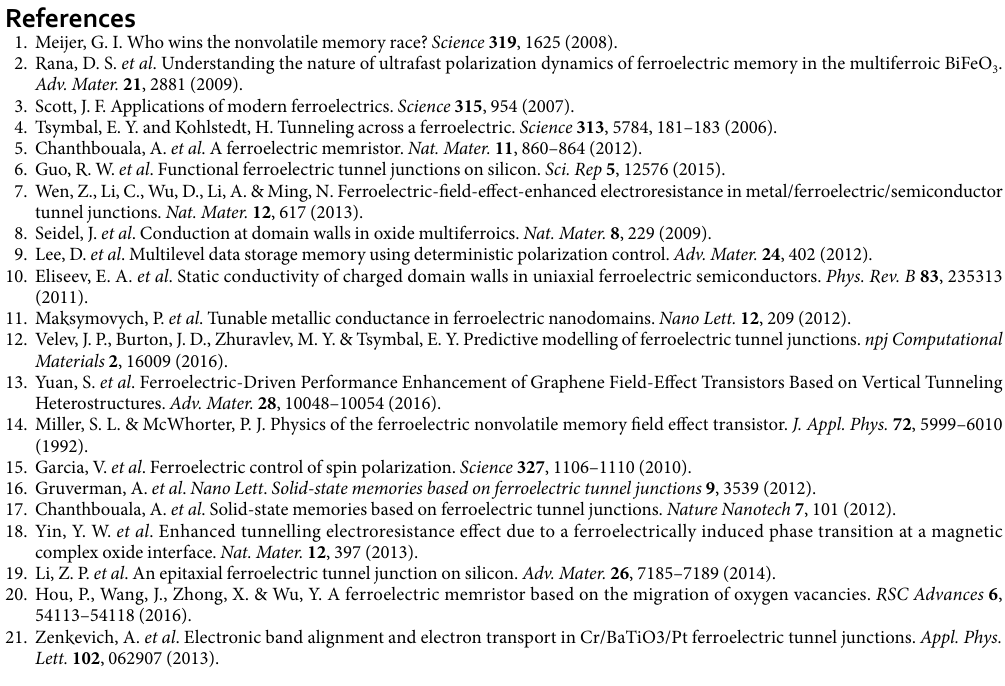
6 Scientific RepoRts | 7: 4525 | DOI:10.1038/s41598-017-04825-z